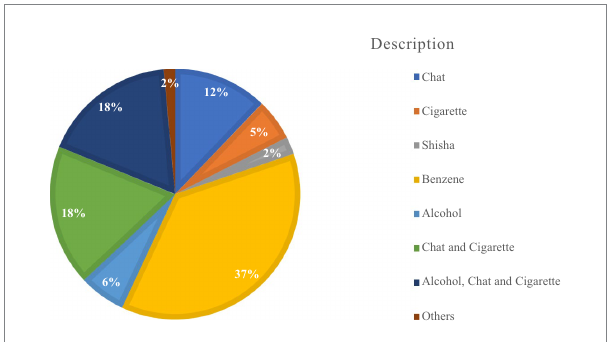
FIGURE 1 The types of substances consumed by the substance user of street children in Wonago town, September 2021 ( N =